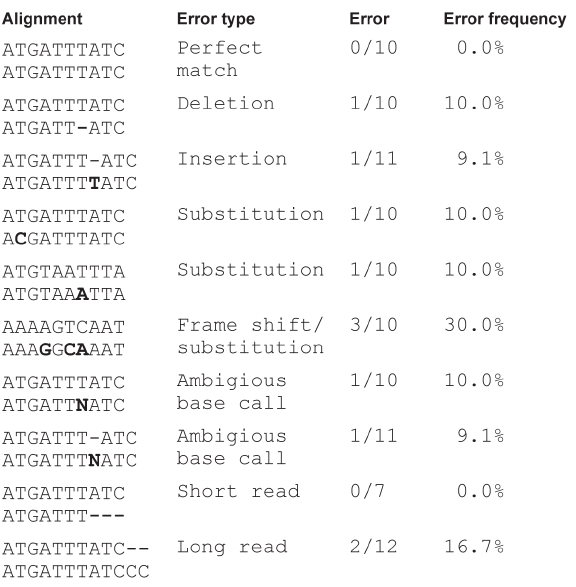
Figure 1. Examples of how different types of UDPS error were defined.